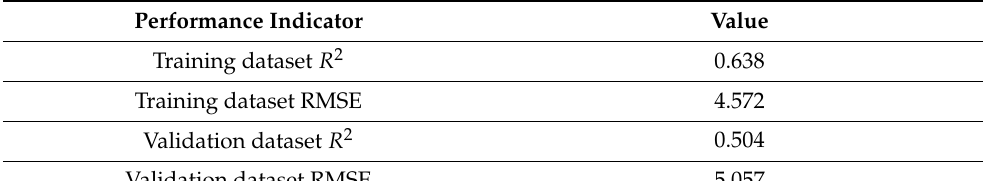
Table 5. Performance indicators of the carbonation model.